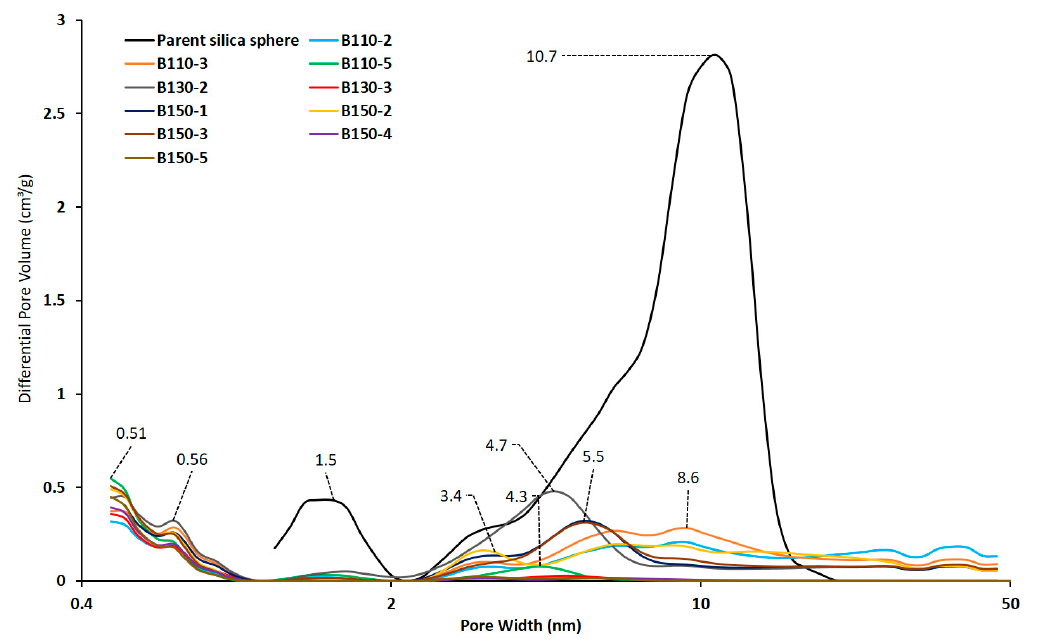
Figure 6. DFT (Density Functional Theory) pore size distributions determined from the adsorption branch of the N 2 isotherms of calcined silicalite ‐ 1 beads obtained by pseudomorphic transformation at different temperatures (T) and durations (time in days) (B ‐ T(°C) ‐ t(days)) compared to the parent silica bead. Table 2. Textural properties of the calcined materials synthetized by pseudomorphic transformation and of the parent amorphous silica spheres. Silicalite ‐ 1 beads are presented as a function of their temperature and duration synthesis (B ‐ T(°C) ‐ t(days).